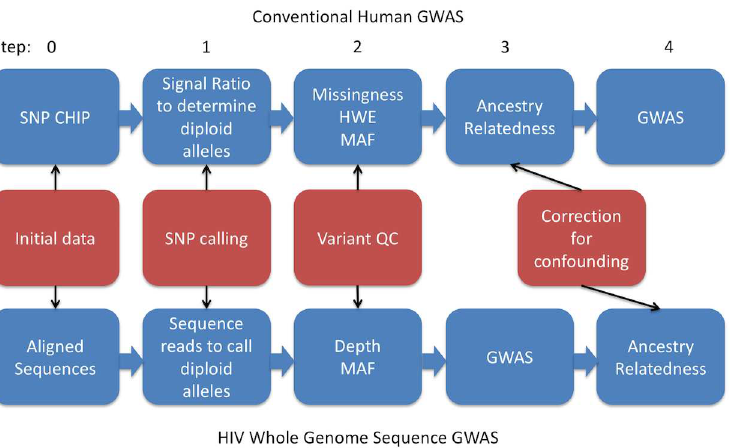
Fig 1. Analysis pipeline for HIV whole genome sequence (WGS) genome-wide association study (GWAS) compared to a human study using a SNP chip. Step 1) Diploidydefined for both human and pathogen, to reflect ‘real’ heterozygosity and heterozygosity from within host viral diversity. 2) While missingness and Hardy-WeinbergEquilibriumare used to assess genotyping quality in human GWAS, in viral GWAS we used depth of sequencing to assess variant calls. As such, higher calling confidence is associatedwith higher missingness in viral SNPs, while the reverse is true in humans. Low minor allele frequency(MAF) is always used to remove variants that have low power to detect effects and may reflect errors. 3&4) Correction for ancestry and relatedness are key to human GWAS, however due to both more homogenous samplingand difficulty in applyingconventional corrections in human data to viral, this was done as a sensitivity test in a smaller sample for top SNPs in HIV